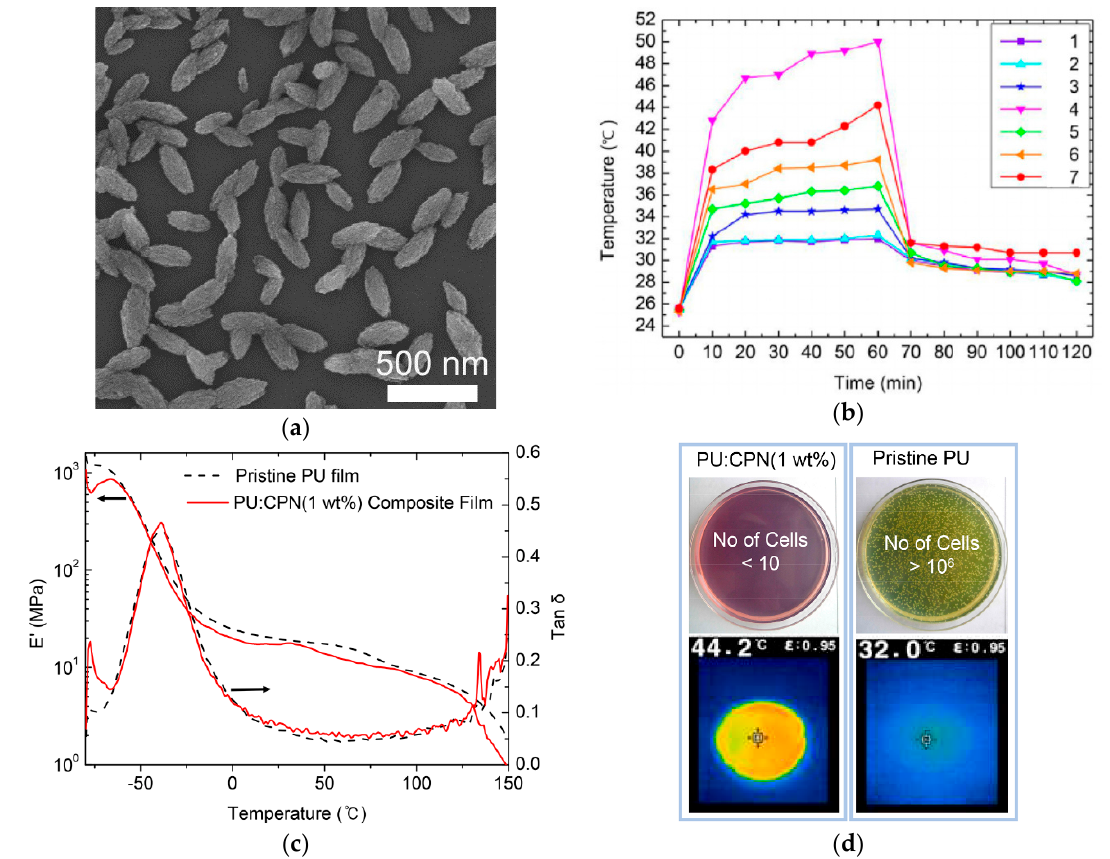
Figure 6. ( a ) Scanning electron microscopy (SEM) image of PCPDTBT nanoellipsoids, ( b )